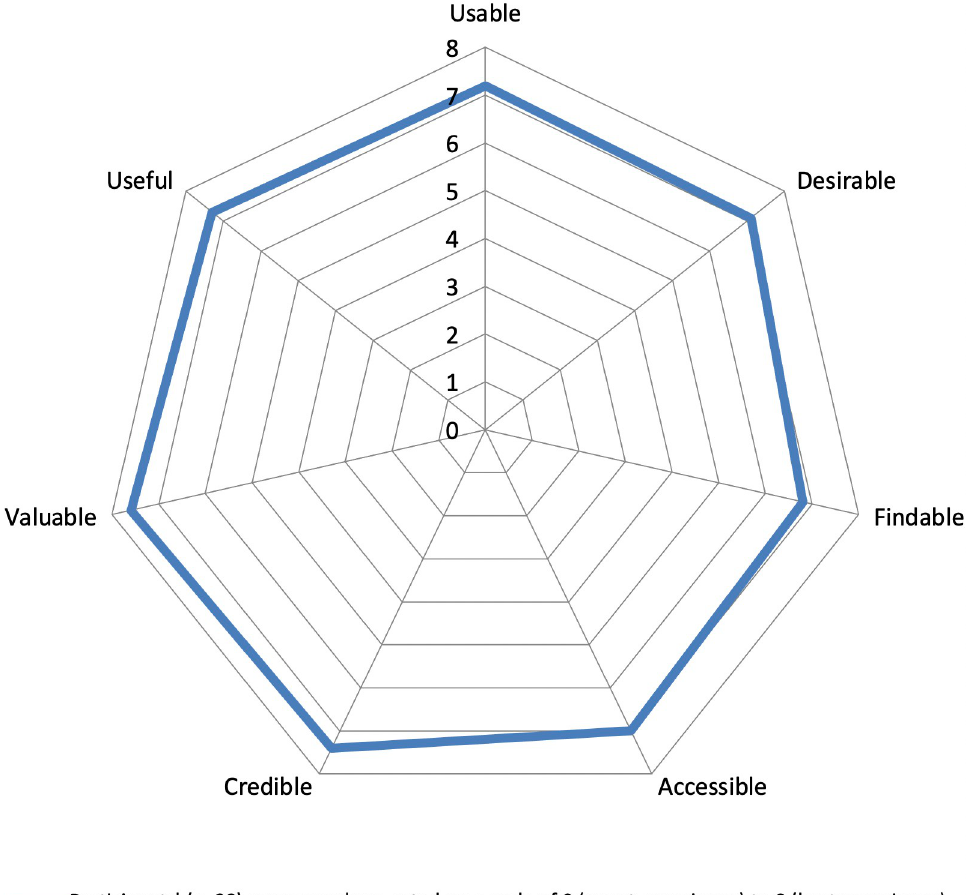
Fig 3. The User Experience Radar [26] with average values for the Honeycomb